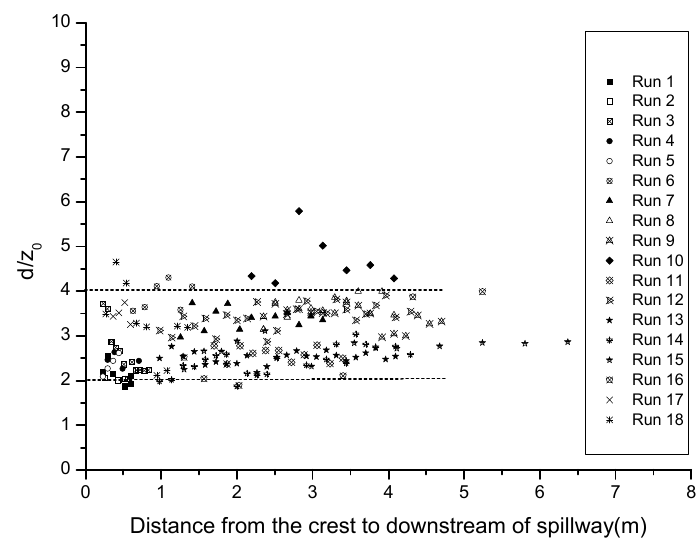
Figure 11. The relationship between d and z 0